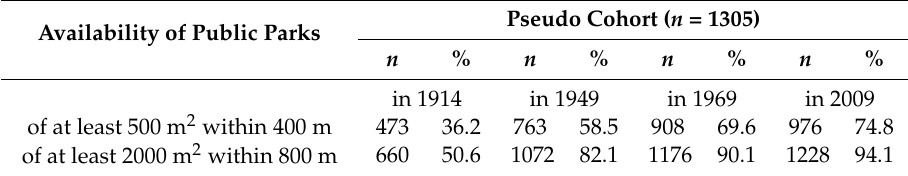
Table 3. Availability of public parks amongst the pseudo cohort for the four survey years.